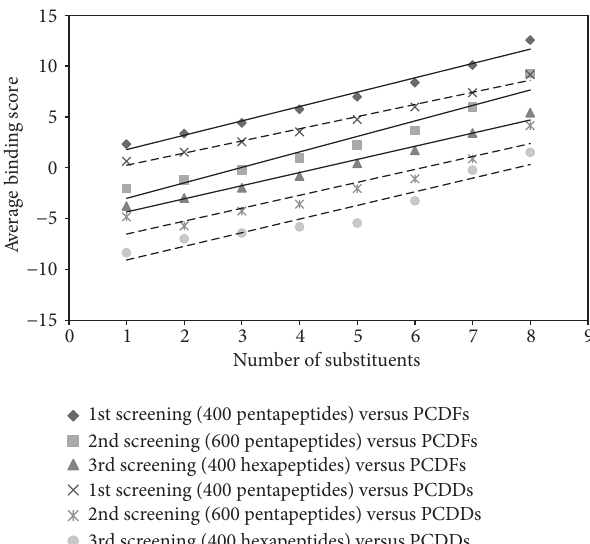
1st screening (400 pentapeptides) versus PCDFs 2nd screening (600 pentapeptides) versus PCDFs 3rd screening (400 hexapeptides) versus PCDFs 1st screening (400 pentapeptides) versus PCDDs 2nd screening (600 pentapeptides) versus PCDDs 3rd screening (400 hexapeptides) versus PCDDs Figure 3: PCDFs and PCDDs number of substituents effect on peptides average binding score. All the three simulation screening steps were reported. The solid lines illustrated the PCDFs trend, the dashed lines the PCDDs